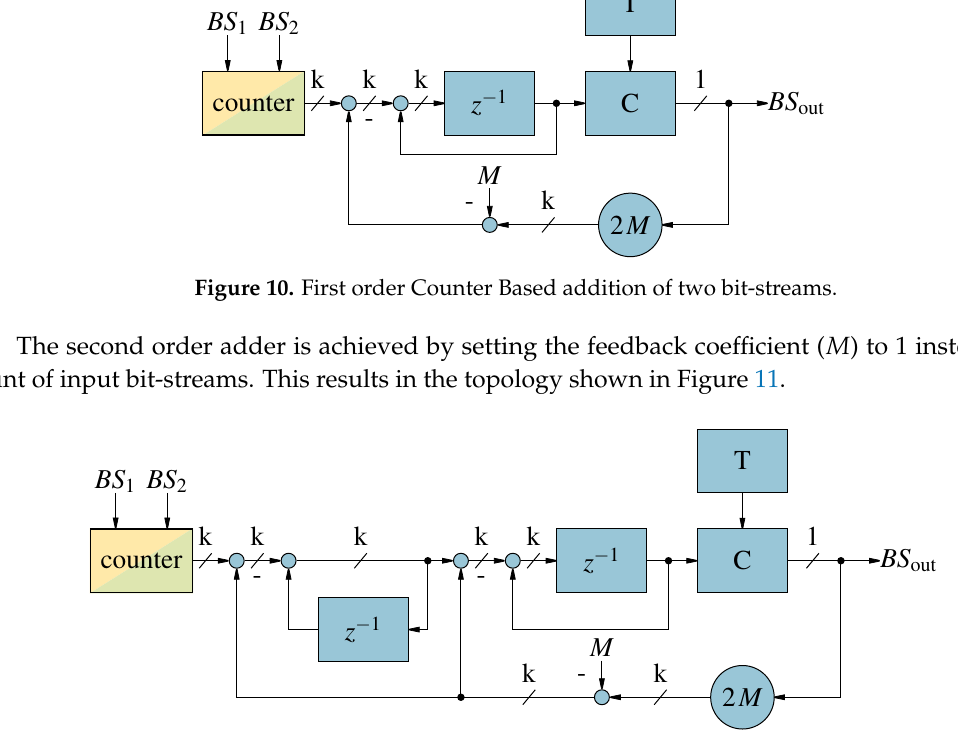
Figure 11. Second order Counter Based addition of two bit-streams.